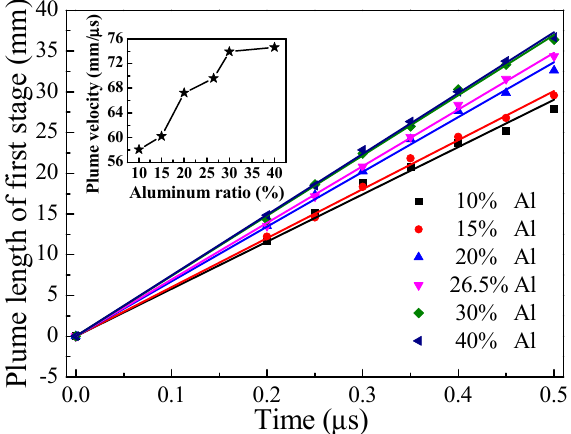
Figure 9. The plume length of the first stage variation with time and its linear fitting at different proportions of Al (ambient pressure 0.005 Pa and laser energy 542.3 mJ).